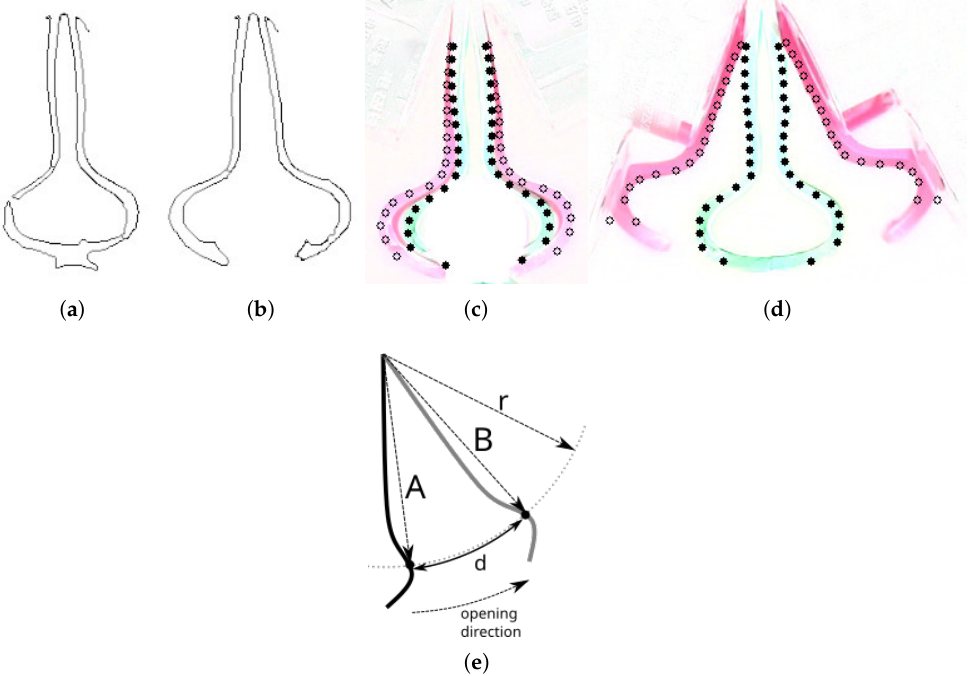
Figure 13. Preprocessing stages of the gripper displacement analysis. Edge image of closed gripper in the base closed position ( a ). Edge image of the closed gripper holding an object ( b ). Difference image between the closed empty gripper and closed gripper holding an object (analysis points marked) ( c ). Difference image between the closed empty gripper and opened gripper (analysis points marked) ( d